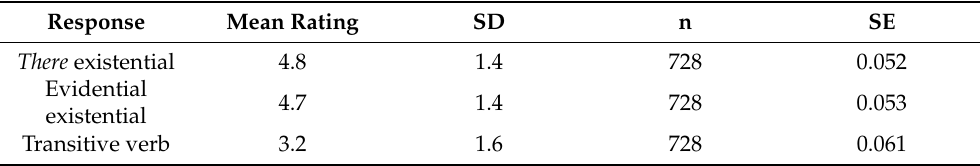
Table A2. Descriptive statistics for evidential existentiality norming study results. Mean is calculated on raw (non-z-scored) ratings.